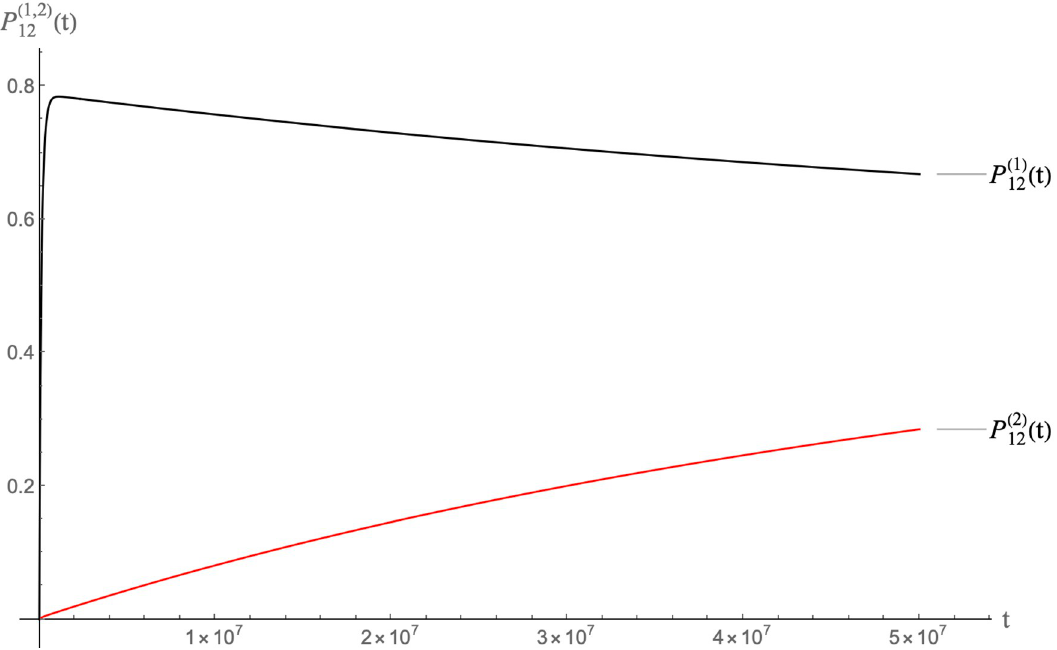
Fig 11. Same as the previous figure but on a time scale of 10 7 units.